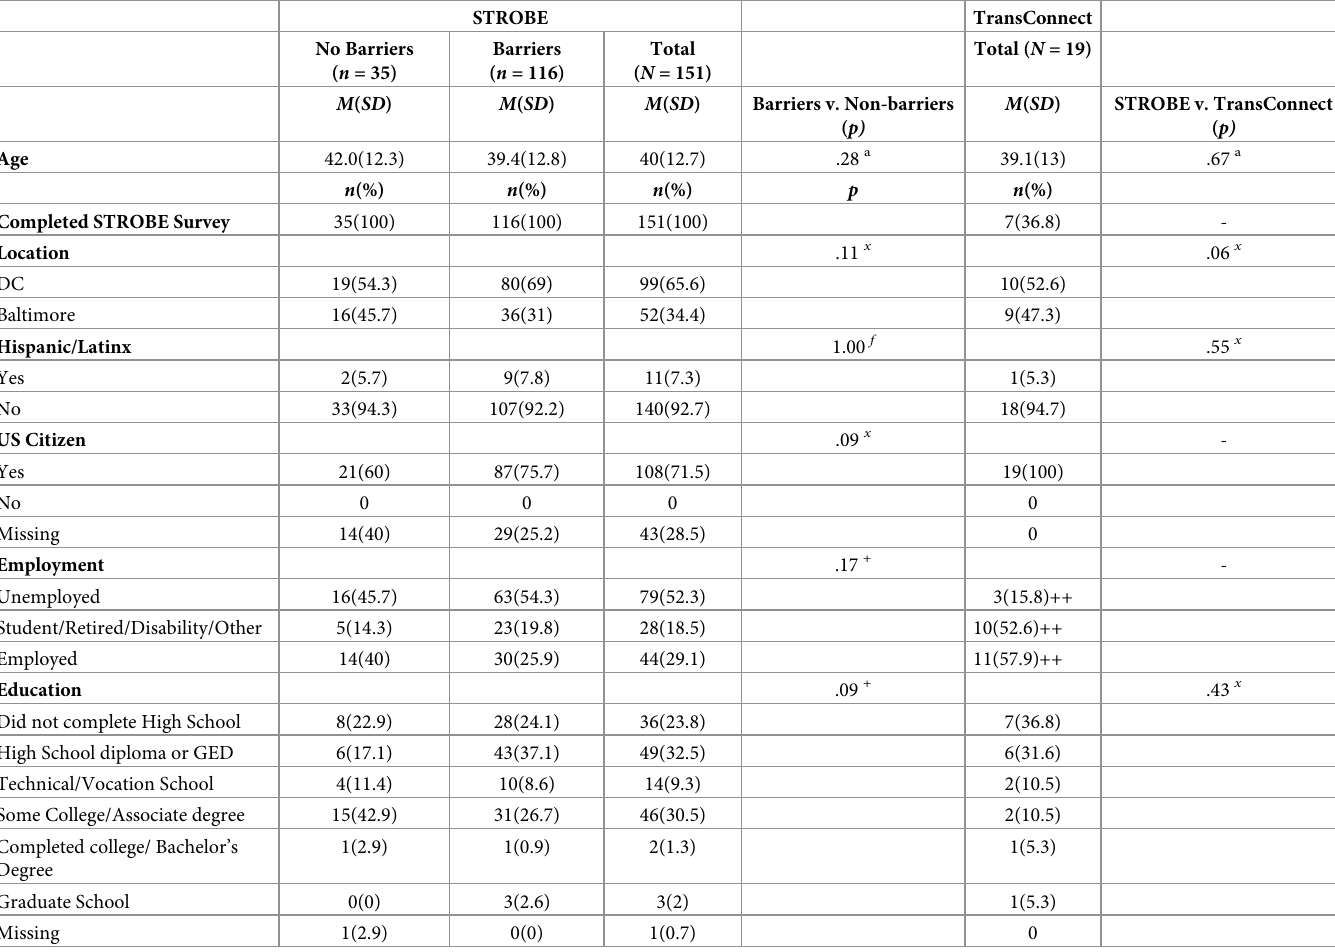
Table 1. Demographics among Black transgender women among included STROBE Participants (N = 151) and included TransConnect participants (N =